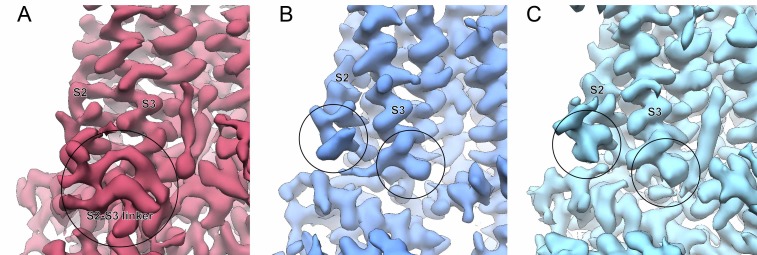
Structural divergence between TRPV5 and TRPV6 at the S2-S3 linker.(A) Cryo-EM density of ZINC17988990-bound TRPV5 in nanodiscs. The S2-S3 linker is circled and labeled. (B–C) Cryo-EM densities of (B) rat TRPV6 in nanodiscs (EMB-7123) and (C) human TRPV6 in nanodiscs (EMB-7120). The end of the resolved cryo-EM density for both the S2 and S3 helices are circled.